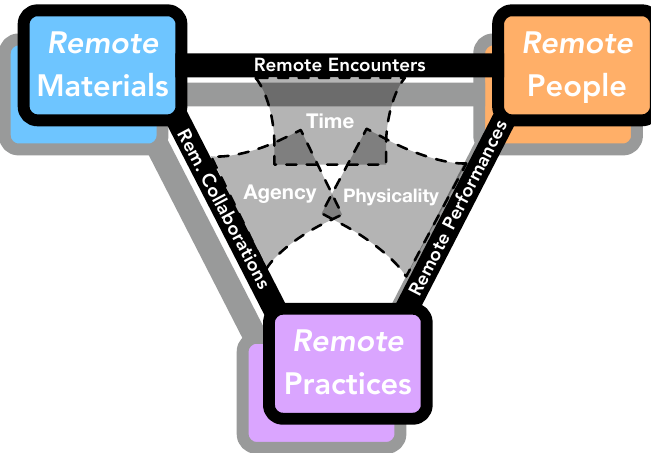
Figure 3. Illustration of the analysis process and corresponding articulation of three design lenses (i.e., physicality, agency and time ) that aim at describing the relations between these domains and related design